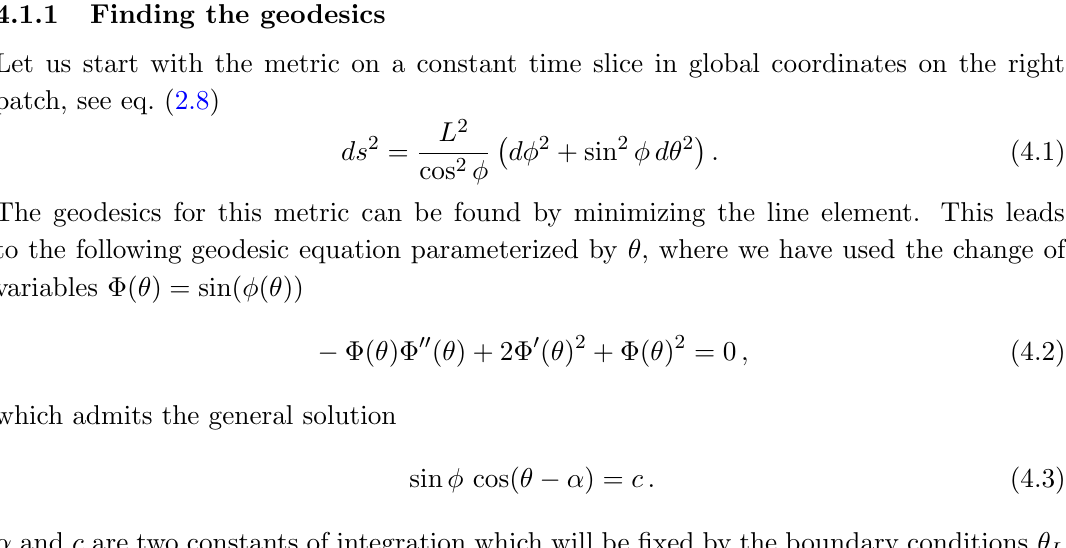
(cid:18) (cid:3) (alternatively r = r ) on the left/right patches respectively. (cid:6) (cid:3) y (cid:3) y < while on the left patch we have < y y (cid:3) . We have (cid:0) (cid:20) 1 (cid:0)1 (cid:20) r . (cid:0)1 (cid:20) (cid:20) 1